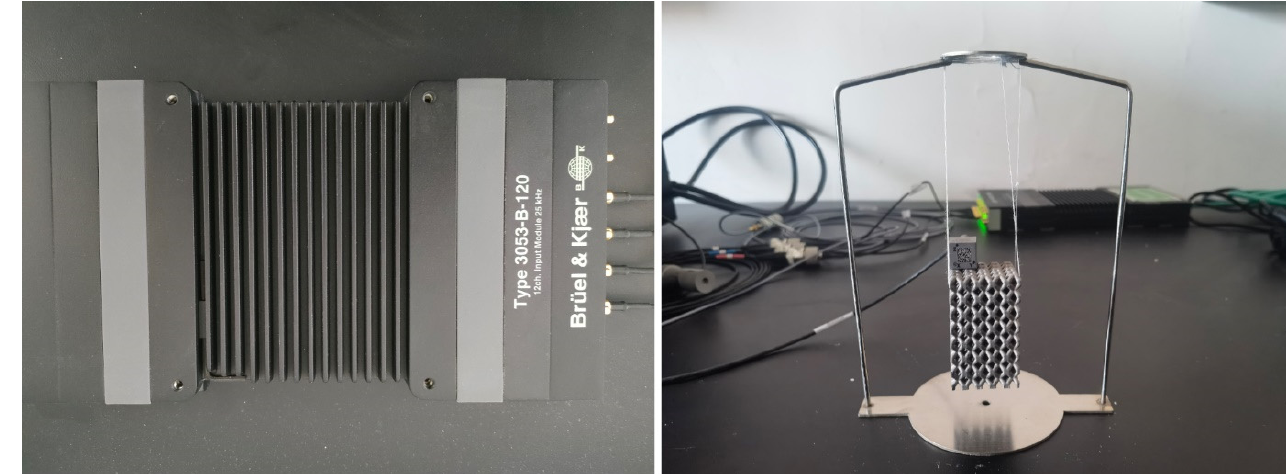
Figure 2. Model test equipment and specimen test.